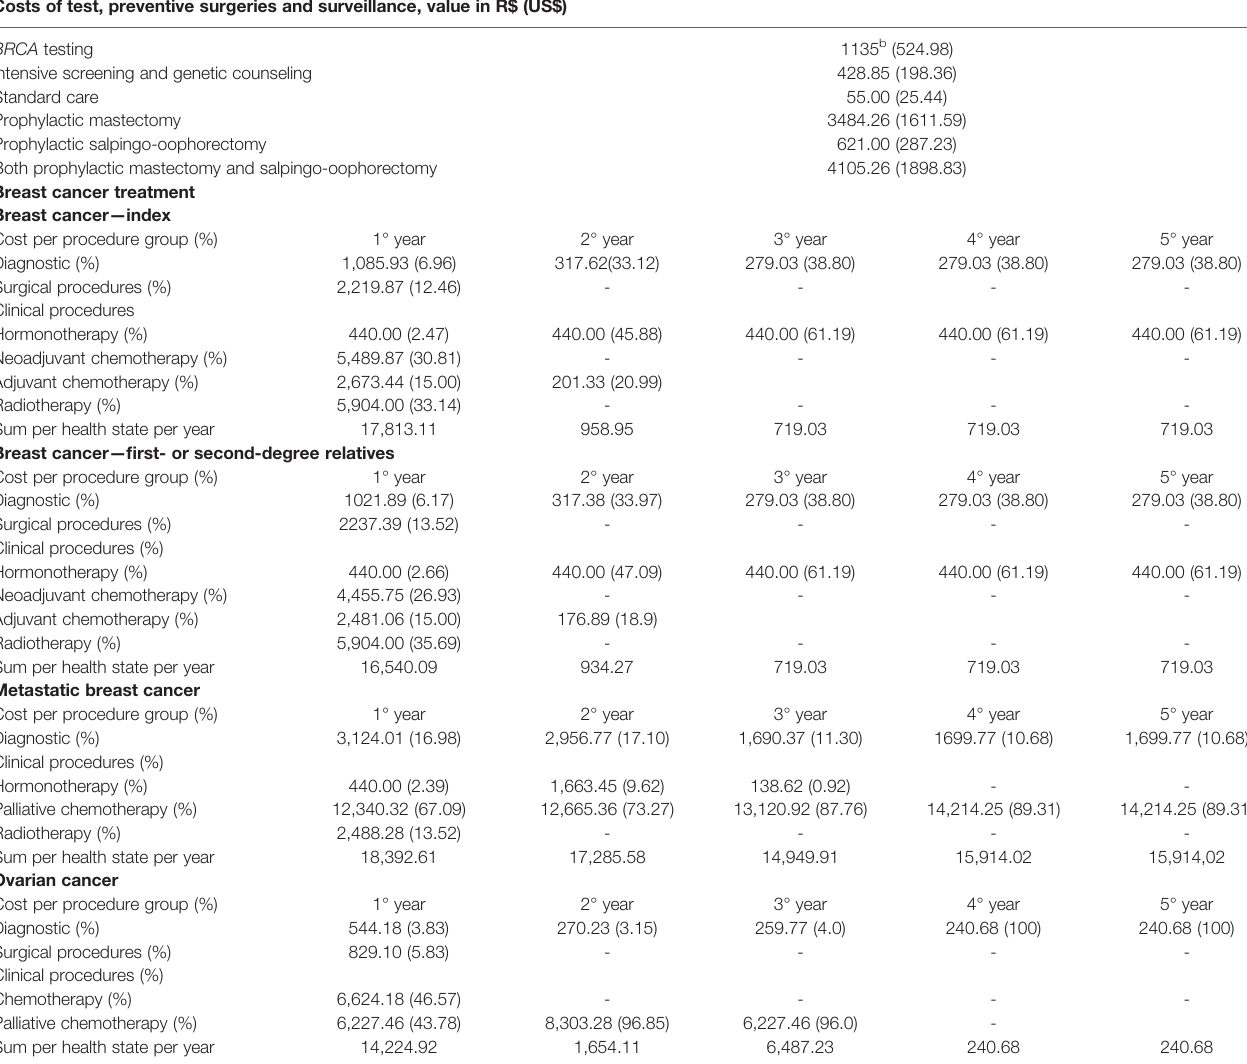
TABLE 2 | Costs a of breast and ovarian cancer (R$ and